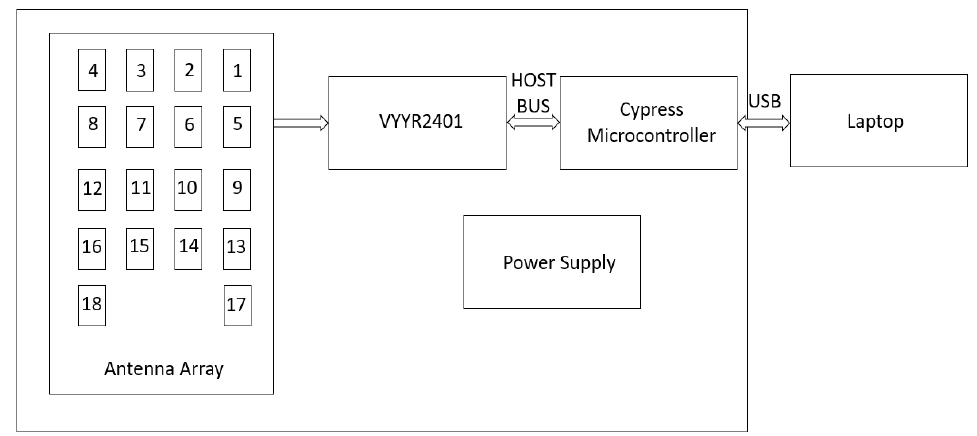
Figure 1. Block diagram of Walabot radar sensor.